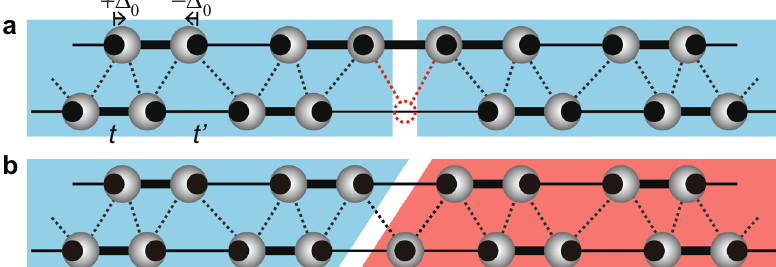
Fig. 1 Schematics of topologically distinct domain walls in coupled dimer chains. a , b Atomic models of domain wall structures a with and b without a single vacancy. Red dotted circle and lines represent a missing atom and its interchain coupling that Huda et al. did not consider in their model. Undimerized (dimerized) atoms in the chains are indicated by black (gray) circles. ± Δ 0 denote the equilibrium dimerization displacements with respect to the undimerized phase. Here, Δ 0 = 0.1 a 0 is the same value as Huda et al. used 1 , where a 0 is the undimerized atomic spacing. t and t 0 indicate intradimer and interdimer hopping parameters, respectively. Blue (red) shaded background means trivial (nontrivial) ground states.